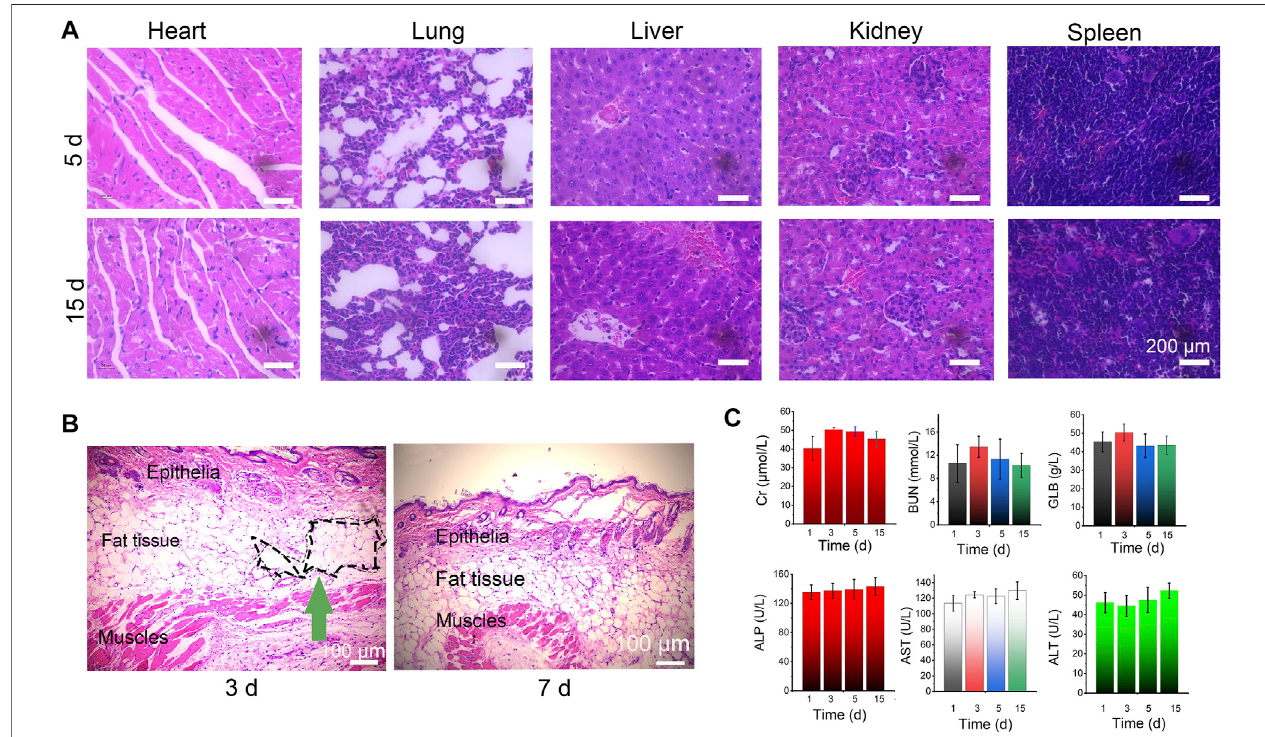
FIGURE7| BiosafetyoftheLido-PPIX@ERhydrogel invivo . (A) ImagesofH&EstainingaftertreatmentwiththeLido-PPIX@ERhydrogel. (B) H&E-stainedsections ofsurroundingtissuesat thesite ofsubcutaneouslyinjected Lido-PPIX@ERhydrogel. Scalebar =100 µm. (C) Kidneyfunction(BUN,Cr, and GLB)and thelevels ofliver (ALP, ALT, and AST) markers on Days 1, 3, 5, and 15 in the control and Lido-PPIX@ER hydrogel treatment groups.